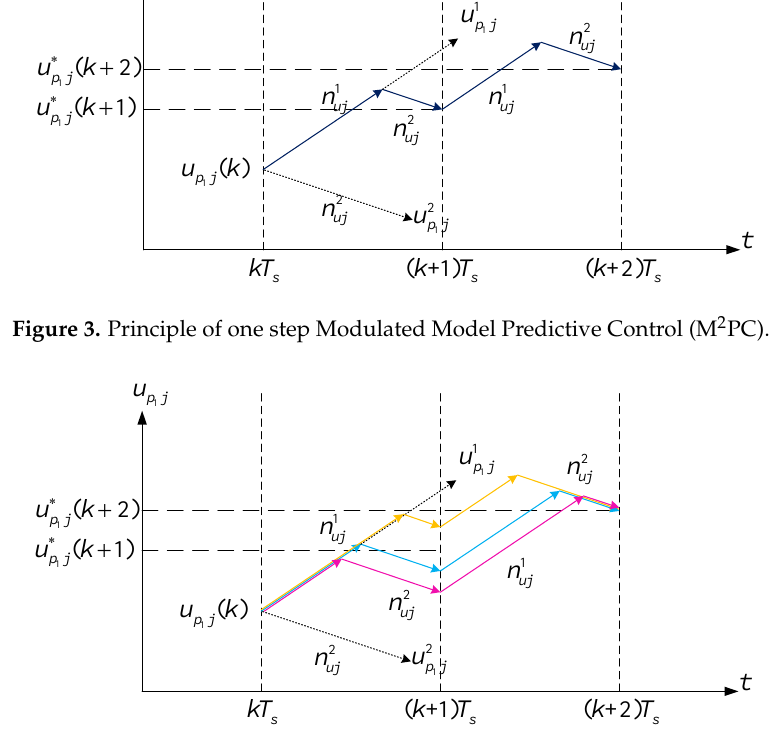
Figure 4. Principle of proposed optimized multi ‐ step M 2 PC.